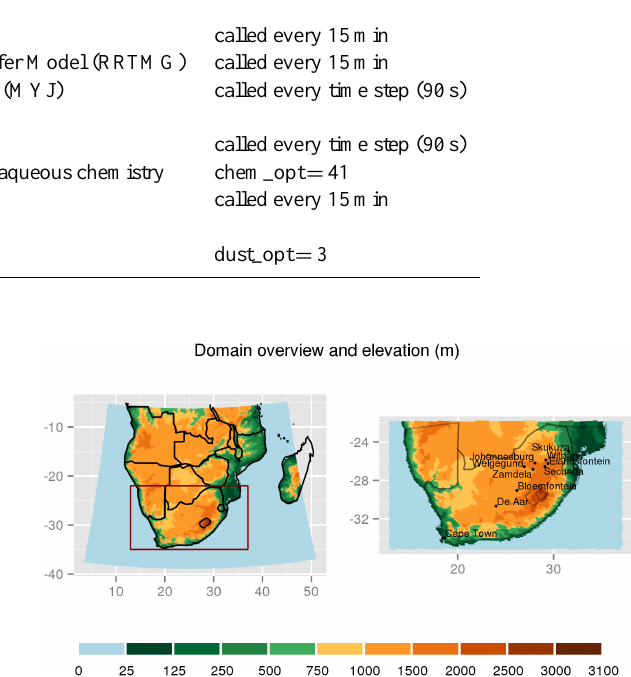
Figure 1. Domain overview and elevation (left), enlarged for South Africa (right), locations of all stations with data used for the model evaluation (see text) and the location of Johannesburg included in the